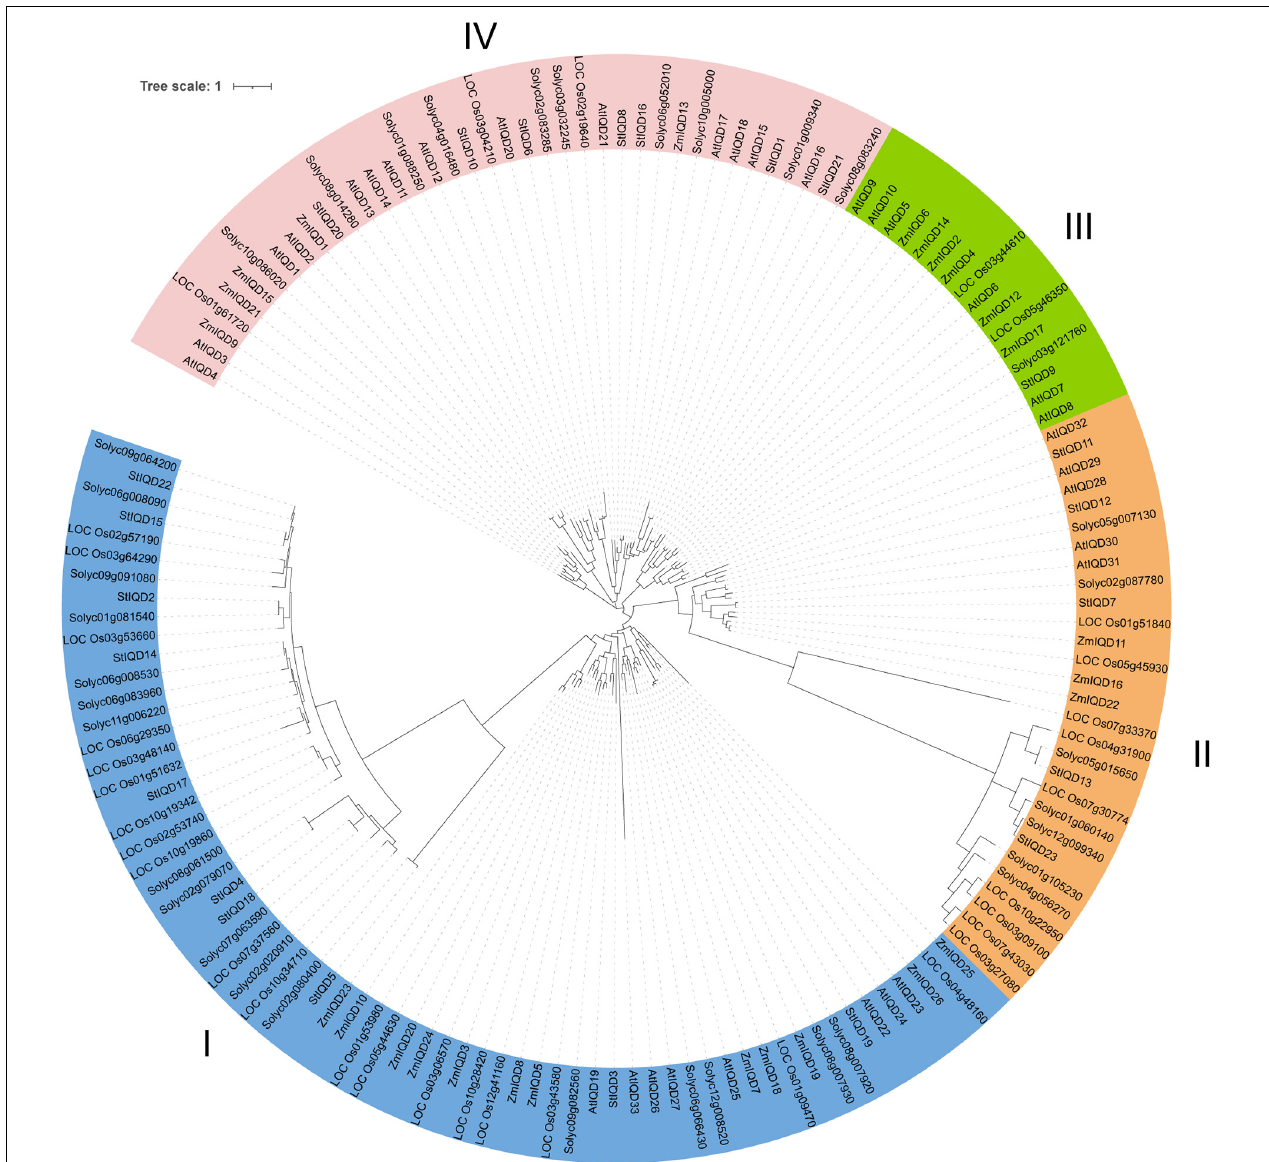
FIGURE 4 | Phylogenetic relationships of IQDs in potato, Arabidopsis , tomato, rice, and